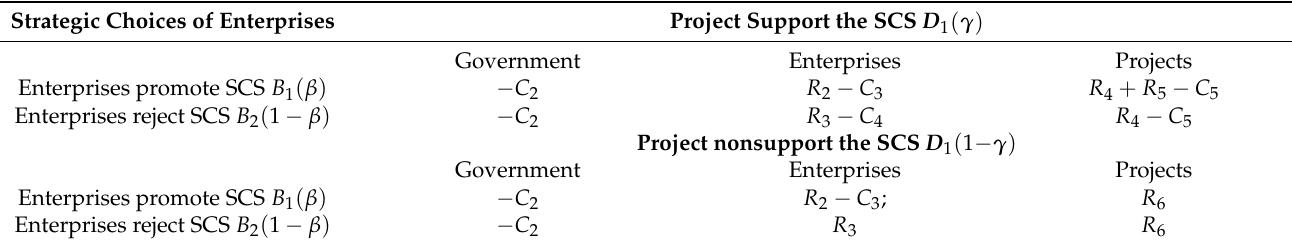
Table 3. Payment matrix under government selective non-intervention